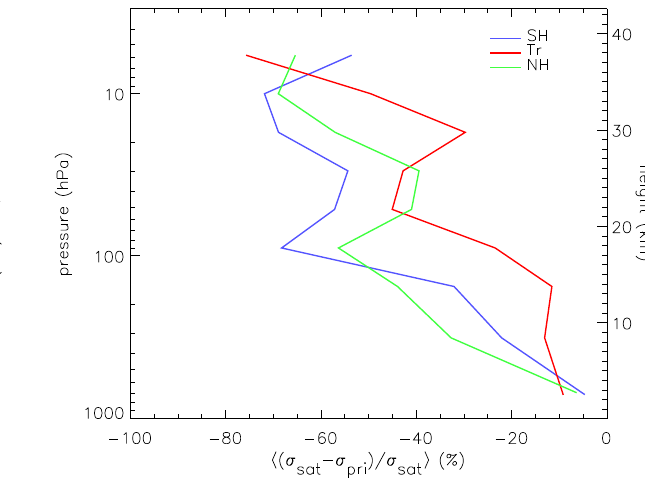
Fig. 10. Mean of the relative error differences per latitude band for GOME-2 retrievals and a priori. The blue line gives the result for the Southern Hemisphere (SH), red for the tropics (Tr) and green for the Northern Hemisphere (NH). Table 5. GOME-2 validation statistics for retrievals done on the green pixels in Fig. 6. Variables are the same as in Table